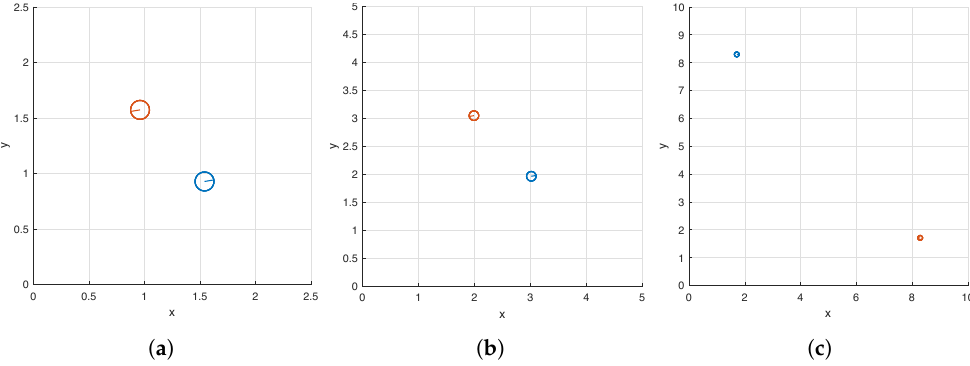
Figure 7. Top views of the optimal carpets consisting of a pair of helices found by the hybrid method. The three panels correspond to three sizes of the flow meter (7): W = 2.5 ( a ), 5 ( b ), and 10 ( c